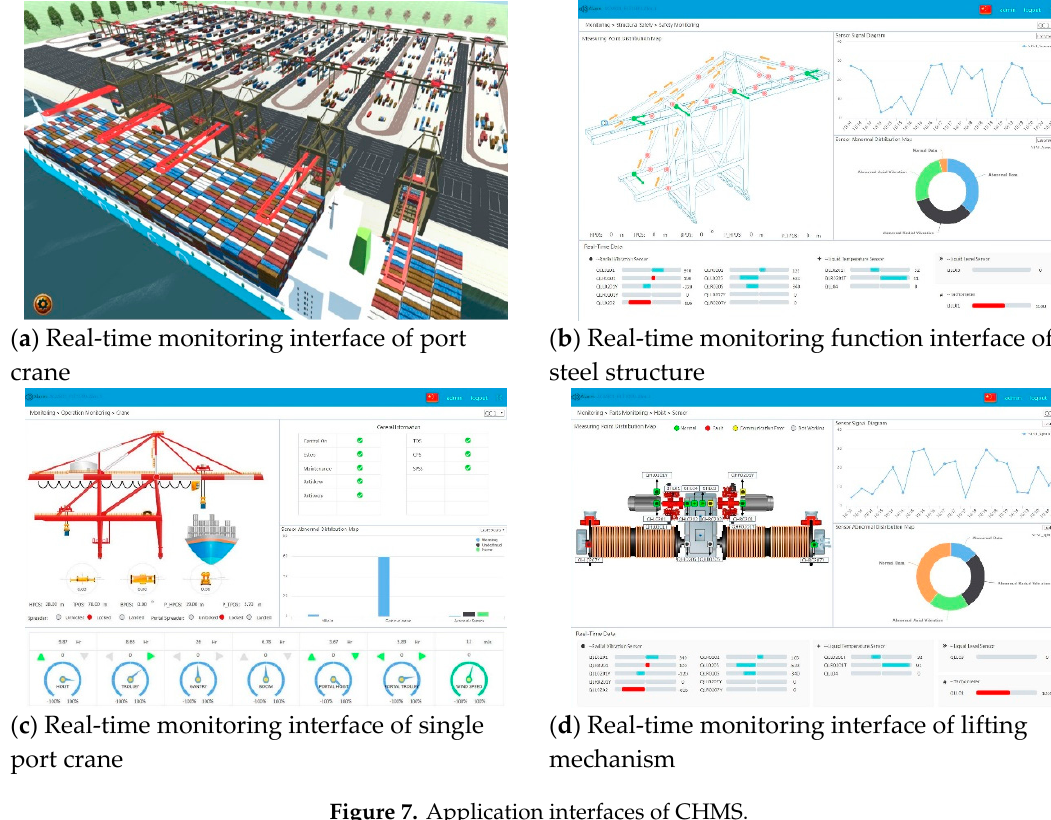
Figure 8. The variation of health degradation.